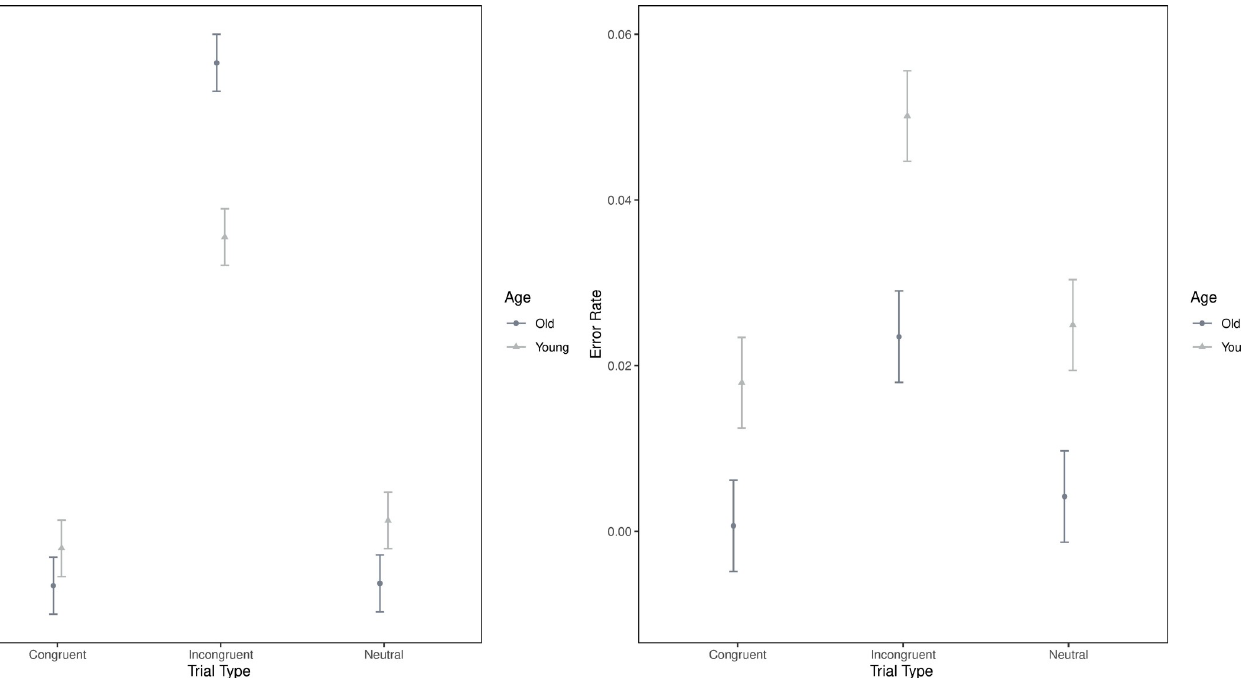
PLOS ONE | https://doi.org/10.1371/journal.pone.0247923 March 2,